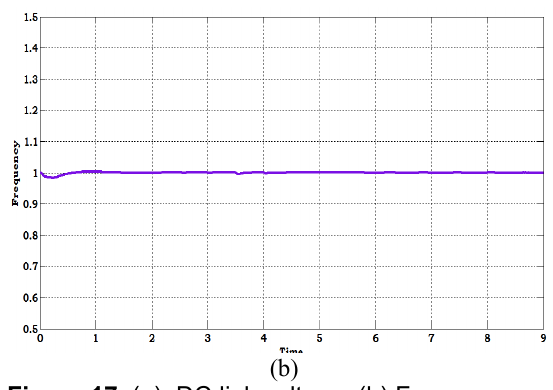
Figure 17. (a). DC link voltage, (b).Frequency There is sudden change in DC link voltage at t=3 sec but controller brings back voltage and frequency in constant. Test Case 3: when operating system in grid connected mode with sudden connection of other units.